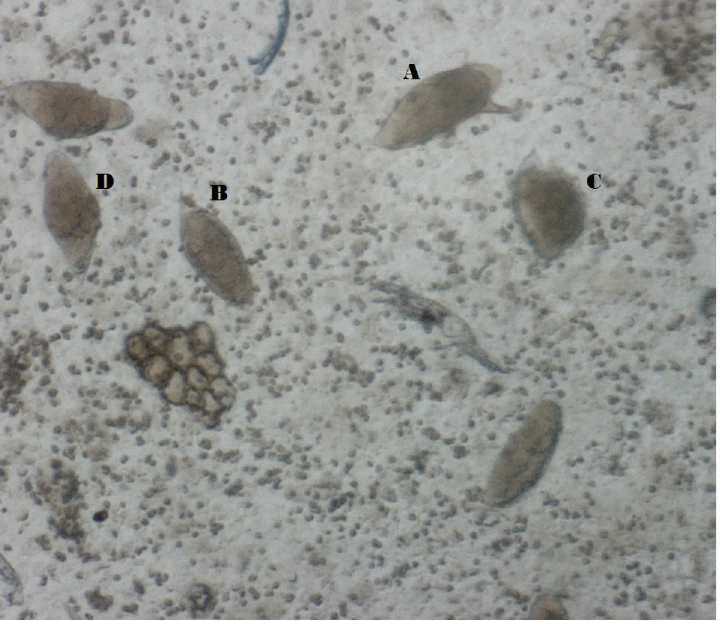
Fig 1. Ectopic egg elimination of S . mansoni in the urine of one of the study participants: A : S . mansoni egg ; B, C, D : S . haematobium